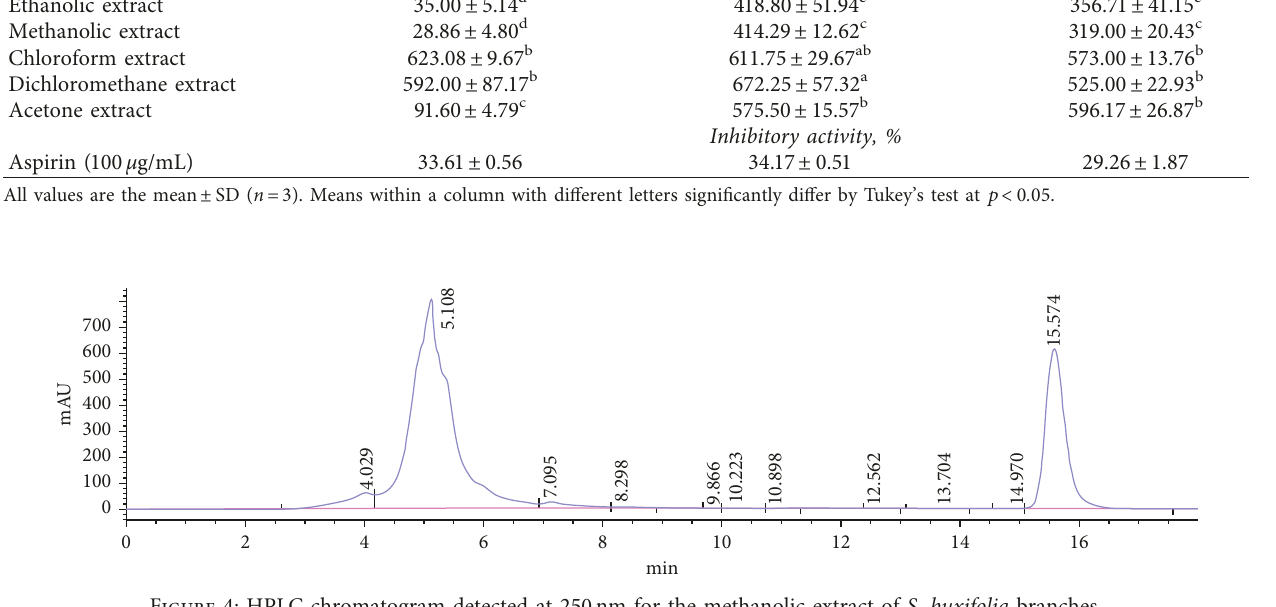
Figure 4: HPLC chromatogram detected at 250nm for the methanolic extract of S. buxifolia